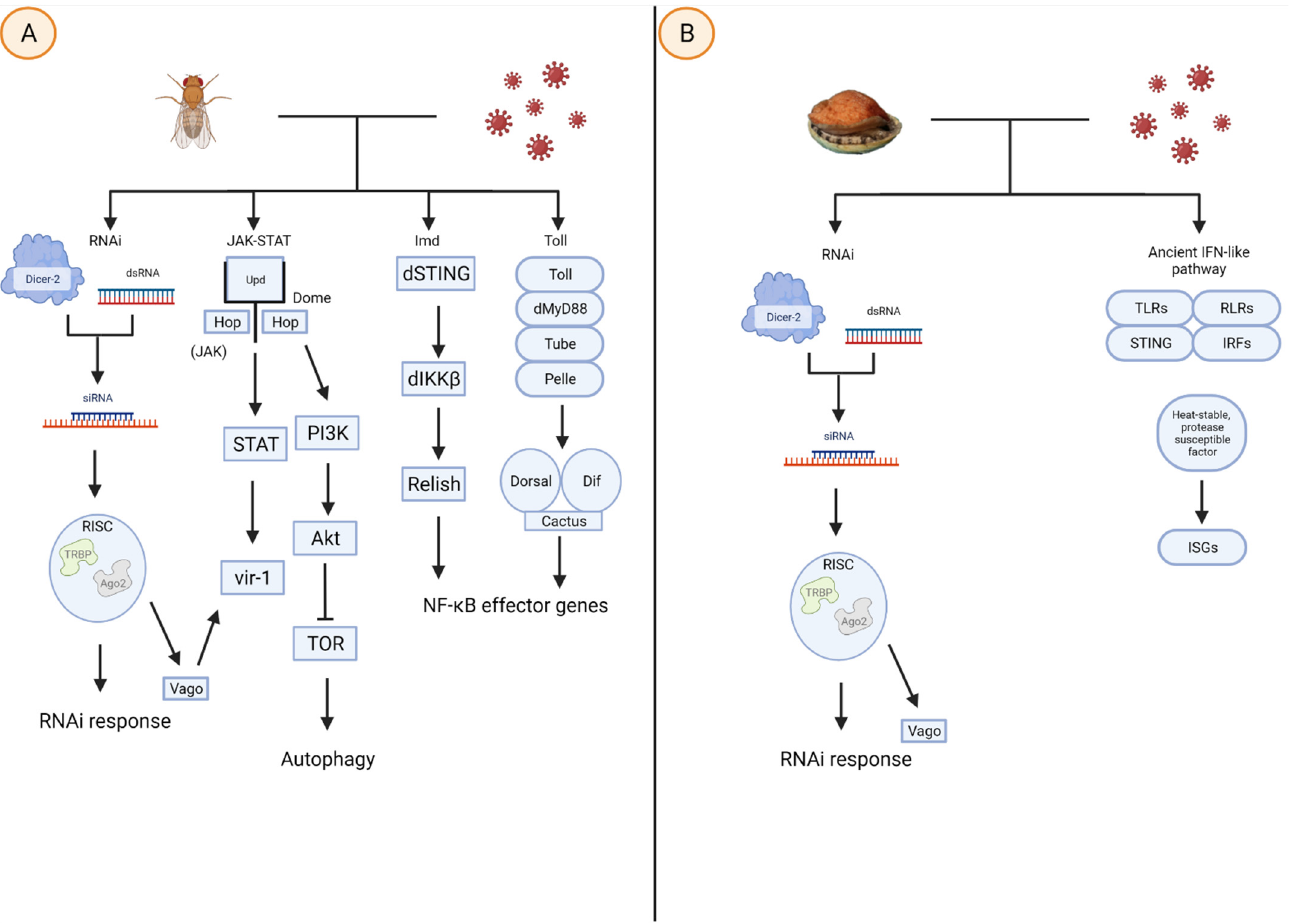
Figure 1. Viral infection in ( A ) D. melanogaster activates the RNAi, JAK-STAT, immune deficiency (Imd), and Toll pathways, whereas ( B ) molluscs rely on the RNAi pathway and homologs of an ancient IFN-like pathway. The RNAi involves Dicer-2 cleaving viral dsRNA to form siRNAs, which interact with RISC to seek and bind to complementary viral mRNA. The JAK-STAT pathway is activated when Upd cytokines bind to Dome, triggering JAK, and, subsequently STAT and vir-1 , the latter of which may also be upregulated by RISC. The JAK-STAT pathway also upregulates PI3K and Akt to mediate TOR, which controls the autophagic response. The NF- κ B effector genes, which in turn regulate cytokine levels and other transcriptional responses, can be upregulated following either the Imd or Toll pathway, the latter of which involves the intracellular signaling cascade of proteins such as dMyD88, Tube, and Pelle. Modified figure derived from [36,37] and created with BioRender.com.